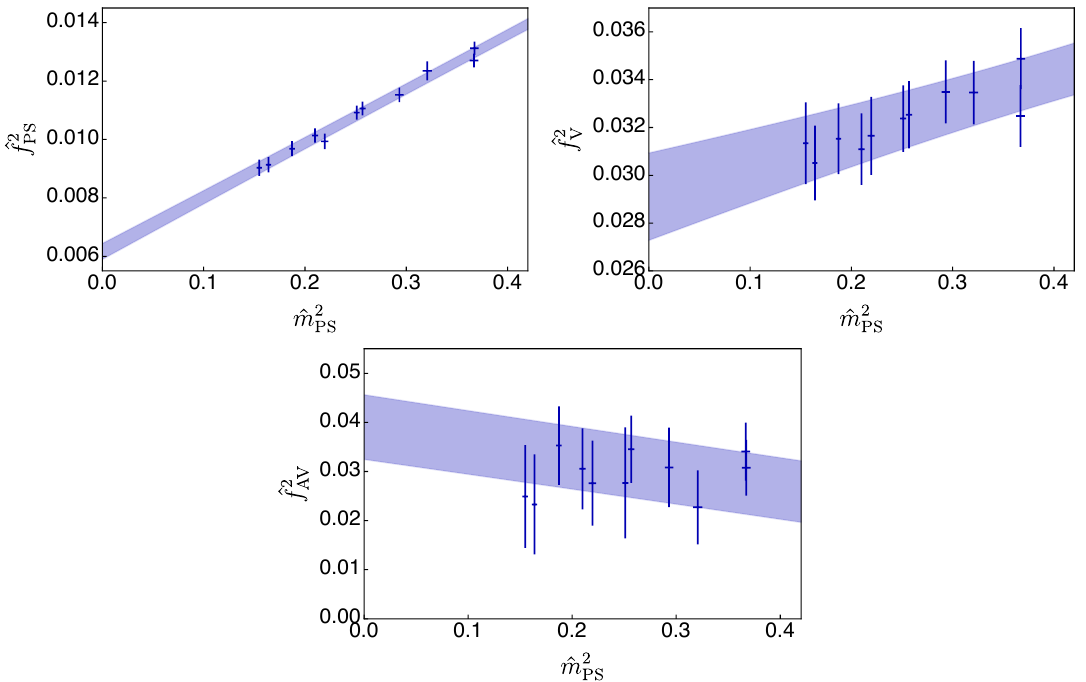
Figure 12. Decay constants squared in the continuum limit | subtracting lattice artefacts due to a (cid:12)nite lattice spacing (see table 9) | as a function of the pseudoscalar mass ^ m 2 represent the statistical uncertainties. The global (cid:12)t results are denoted by shaded bands whose widths indicate the statistical errors.